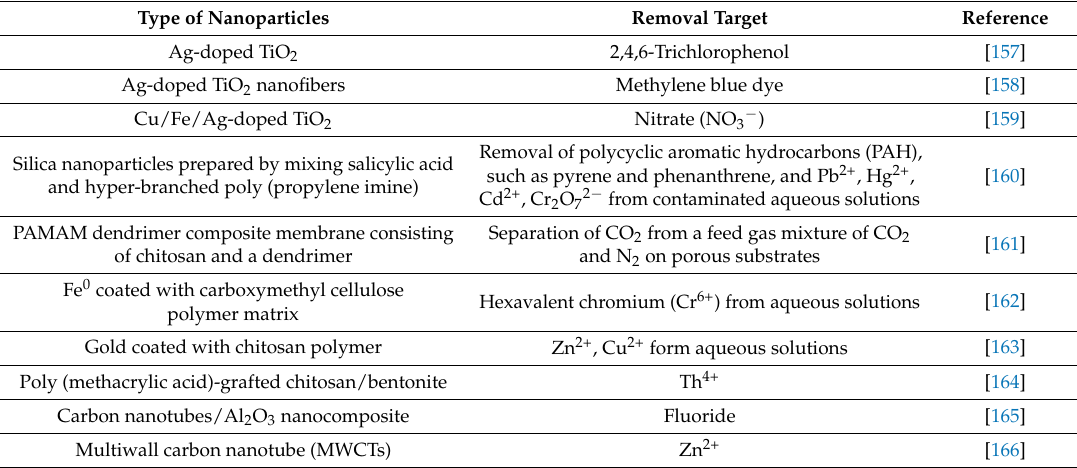
Table 5. Lists of some examples of additional nanomaterials for environmental